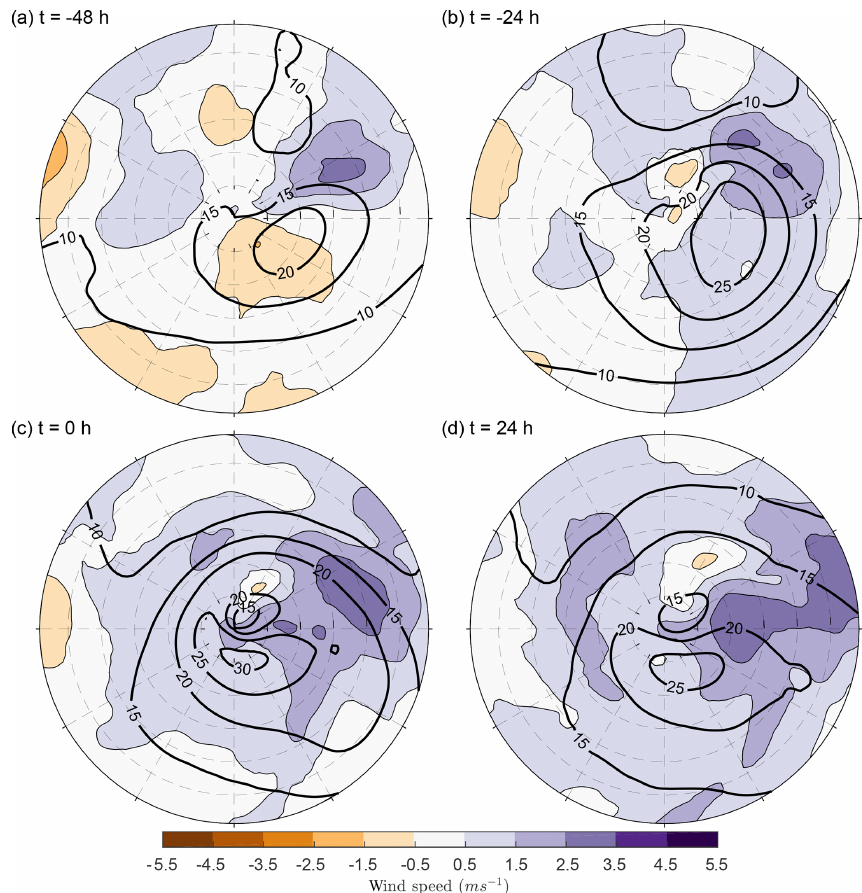
Figure 7. Composite mean of the 900hPa wind speed of the strongest 200 extra-tropical cyclones in the CNTL simulation (black contours, every 5ms − 1 ) and the difference between SST4 and CNTL (shading) at (a) 48h before time of maximum intensity, (b) 24h before time of maximum intensity, (c) time of maximum intensity, and (d) 24h after the time of maximum